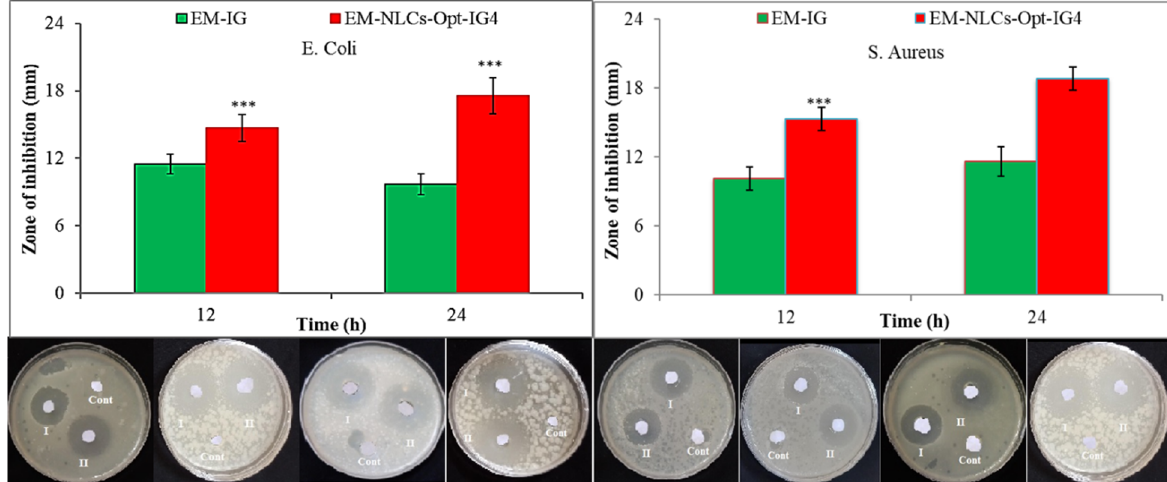
Figure 10. Comparative antimicrobial results of EM-in situ gel (EM-IG) and EM-NLCs-opt-IG4 against S. aureus and E. coli at 12 h and 24 h study. The study performed in triplicate and data shown as mean ± SD. *** p < 0.001 considered as highly significant than EM in situ gel.